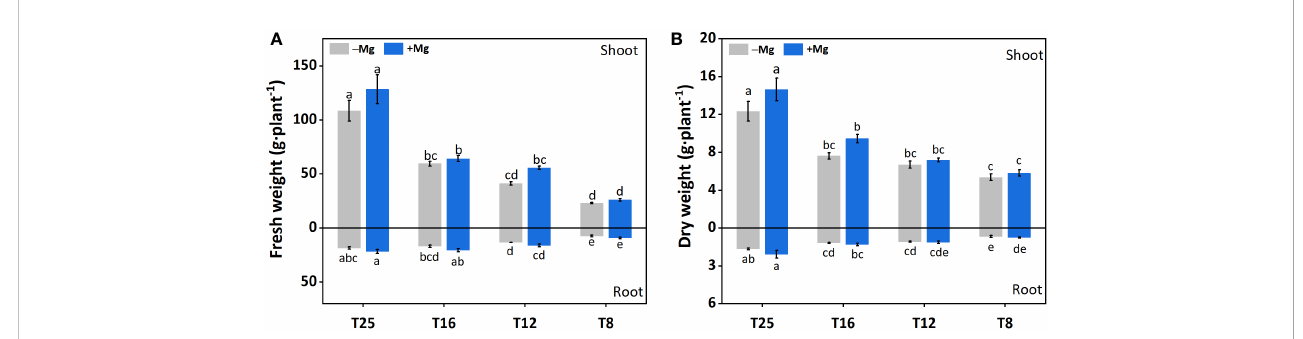
FIGURE 2 Effect of Mg application on tobacco morphological traits under different temperature. (A) root fresh weight (RFW) and shoot fresh weight (SFW); (B) root dry weight (RDW) and shoot dry weight (SDW). The different letters above the bars are indicating signi fi cant difference (Duncan P